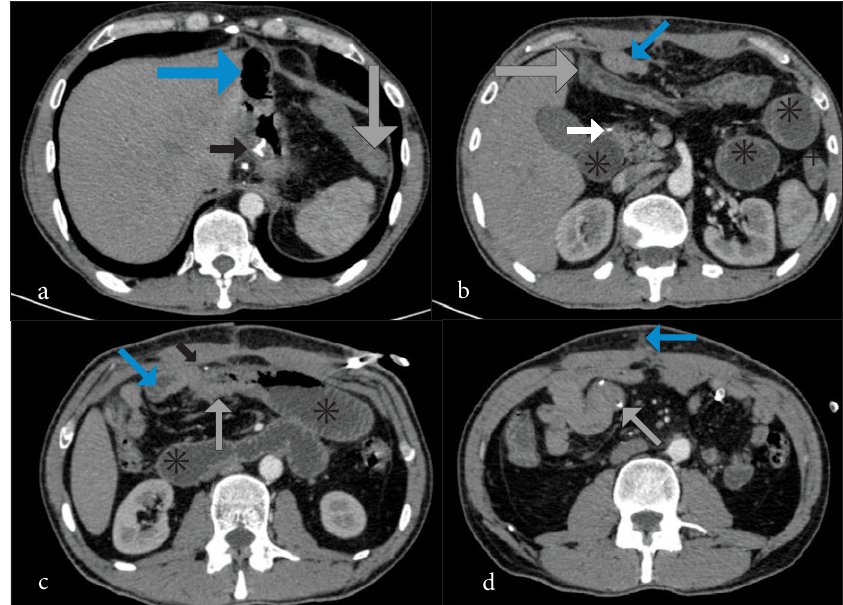
Fig. 2. Axial post-contrast CT images of the abdomen. (a) Fundoplication sutures (thin arrow), empty stomach (broad blue arrow) and collapsed splenic flexure of colon (broad grey arrow). (b) Suture in duodenal stump (thin blue arrow), distended duodeno-jejunal afferent limb (*), undistended pre-colic efferent limb from gastric remnant (broad blue arrow), collapsed transverse colon (broad grey arrow) and descending colon (+). (c) Distended duodeno-jejunal afferent limb (*) crossing between SMA and aorta and Fig. 1. Planning view showing surgical drain minimally distended pre-colic efferent limb (broad blue arrow) from gastric remnant, with transition point (thin arrow), isolated distended small bowel loop (broad grey arrow) in region of anastomotic staple (thin arrow). (d) Undistended gastrojejunostomy blind (broad blue arrow), and small hiatus hernia limb with sutures (broad grey arrow) and surgical scar (broad blue arrow), drain (thin arrow) and no other (broad grey arrow). distended